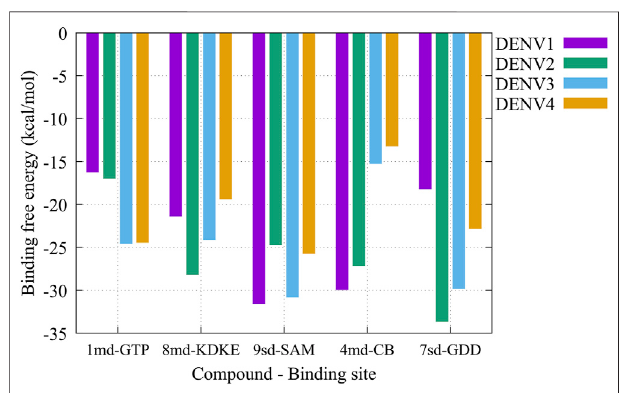
FIGURE 10 | Binding-free energy obtained from the MMPBSA method for the simulated protein – ligand complexes. Major pharmacophore patterns for each binding